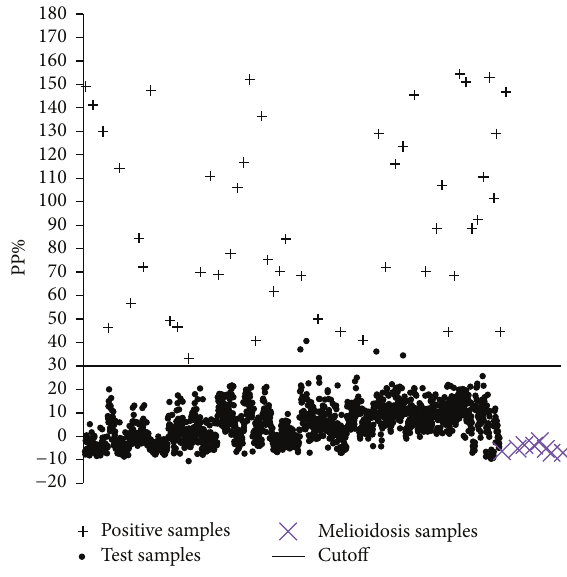
Figure 5: Distribution of PP% value of positive and negative serum samples. The horizontal line represents the cutoff value [percent positivity (PP% = 30)]. Glanders positive serum is indicated by + sign, dot represents the test serum samples, and melioidosis positive human serum is indicated by ×